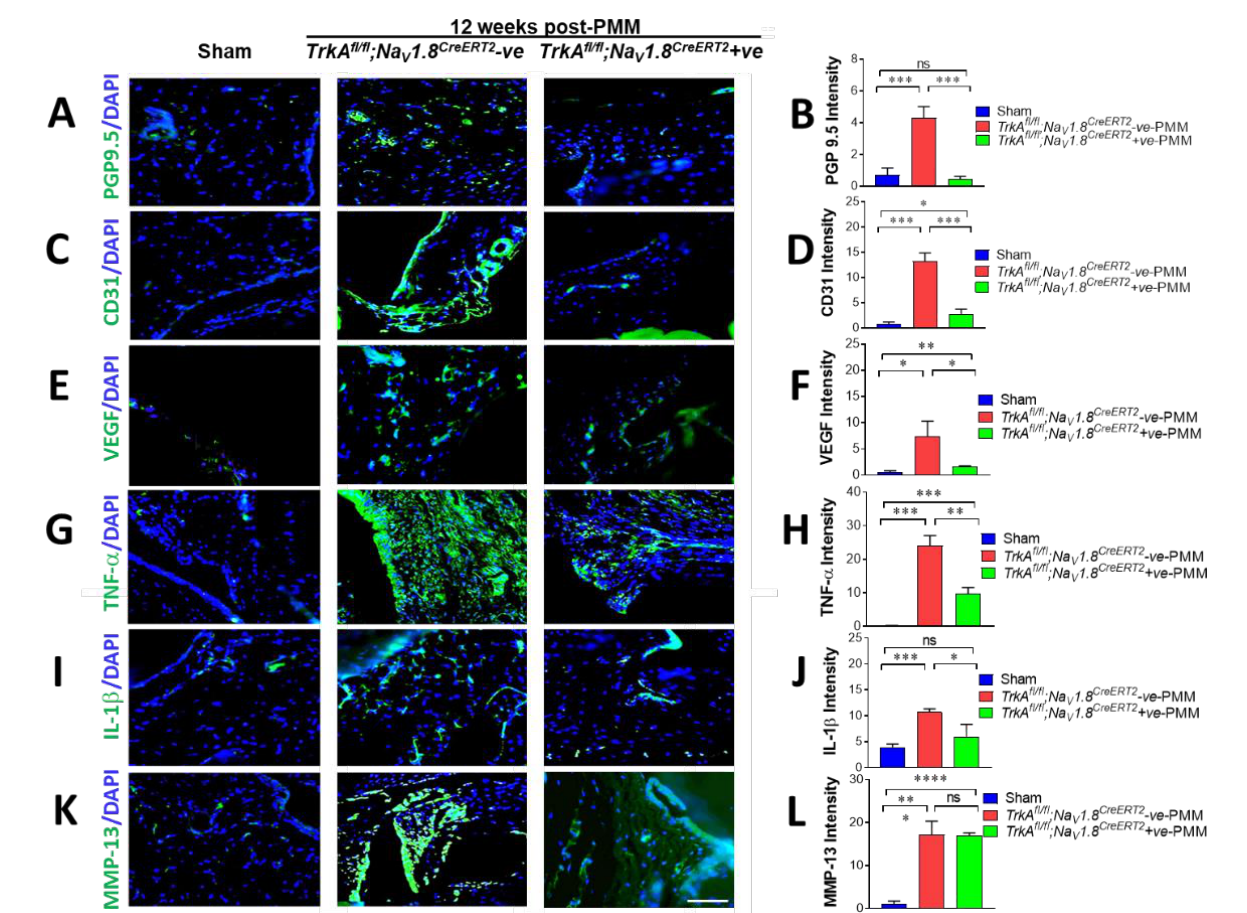
Figure 5. Immunofluorescence staining of peripheral nerve fiber sprouting, angiogenesis factor, pro- inflammatory cytokines, and MMP-13 in osteoarthritis (OA) synovium correlated with decreased joint pain sensation in OA. Reduced PGP9.5 ( A , B ) expression in joint tissues indicated less synovial sensory fiber and downregulated neural fiber. ( A ) Representative immunofluorescence images of staining for PGP9.5 (green) in knee joint synovium of TrkA fl/fl ;Na V 1.8 CreERT2 -negative ( n = 9) and TrkA fl/fl ;Na V 1.8 CreERT2 -positive ( n = 12) mice. ( B ) Quantitative analyses of nerve fiber sprouting. The density of PGP9.5 fibers of TrkA fl/fl ;Na V 1.8 CreERT2 -negative mice exhibited a significant increase in synovial/capsular regions compared to TrkA fl/fl ;Na V 1.8 CreERT2 -positive mice. PGP9.5+ nerve fiber density was calculated as the intensity of the nerve fiber area. 4′,6 -Diamidino-2-phenylindole (DAPI) stained nuclei blue. *** p < 0.001. ( C – F ) Reduced angiogenesis factor CD31 ( C ) and VEGF ( E ) and quantification of CD31 ( D ) and VEGF ( F ) expression in joint tissues indicated decreased innervation and angiogenesis markers. Significantly decreased expression of both CD31 and VEGF (green; ( C , E )) in the knee joint synovium of TrkA -deleted mice after PMM compared to TrkA fl/fl ;Na V 1.8 CreERT2 -negative control mice. Each group: n = 5. Quantitative analysis of CD31 ( D ) and VEGF ( F ) expression in the synovium. ( G – L ) Pro-inflammatory cytokines TNF- α , IL-1 β , and cartilage-degrading enzyme MMP-13 correlated with the unprotected joint pathology. Representative immunofluorescence im- ages of tumor necrosis factor- α (TNF- α ) (green) expression in the synovium of TrkA fl/fl ;Na V 1.8 CreERT2 - positive mice and TrkA fl/fl ;Na V 1.8 CreERT2 -negative control mice are shown in ( G ). Each group: n = 5. Quantitative analyses of TNF- α expression in cartilage and synovium ( H ). ( I ) Represen- tative immunofluorescence images of interleukin (IL)-1 β expression (green) in cartilage and syn- ovium of TrkA fl/fl ;Na V 1.8 CreERT2 -positive mice and TrkA fl/fl ;Na V 1.8 CreERT2 -negative control mice are shown. Each group: n = 5. ( J ) Quantitative analyses of IL-1 β expression in cartilage and